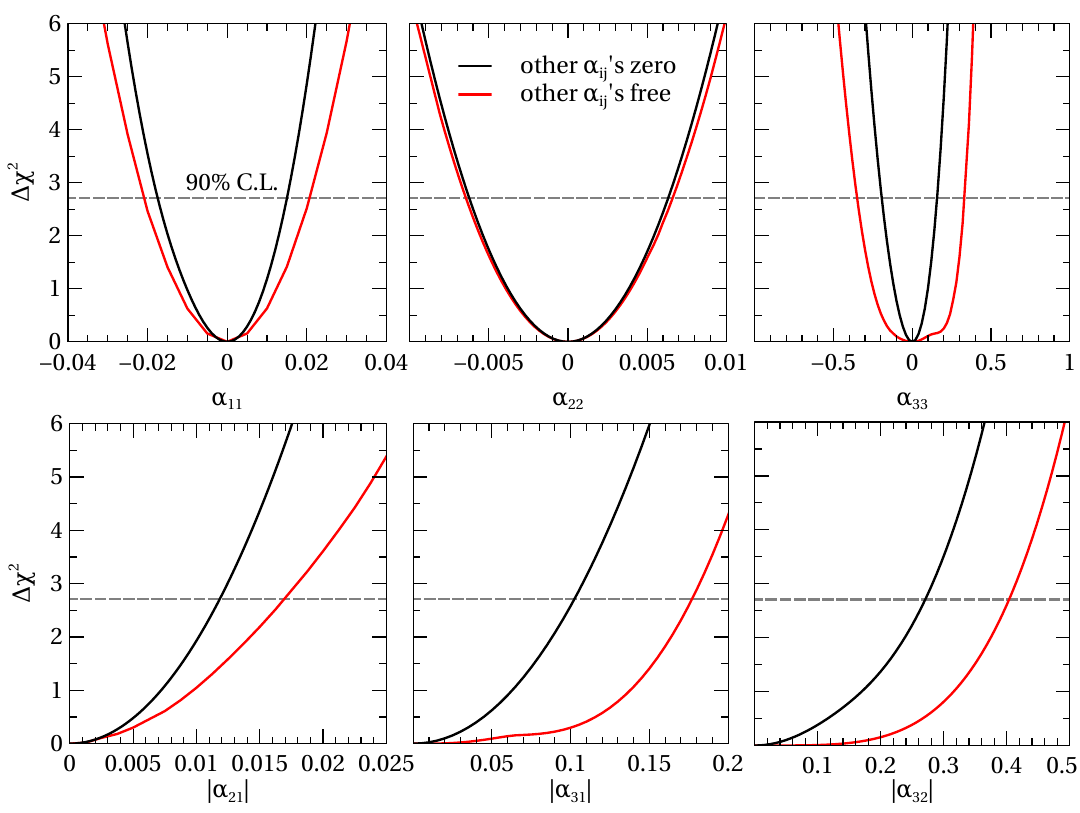
Figure 10 . The combined sensitivity of DUNE and JD+KD setups to the NUNM parameters. True values of the standard oscillation parameters are given in table 2. We marginalize over θ and δ in the fit (see text for details). Black curves show the sensitivity when only one NUNM CP parameter is considered at a time, while the others are taken to be zero. Red curves in all the panels correspond to the case when all other NUNM parameters are kept free in the